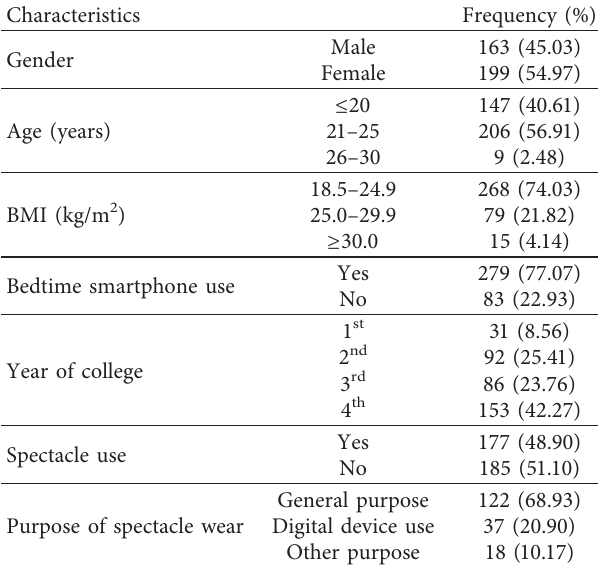
Table 1: Characteristics of study